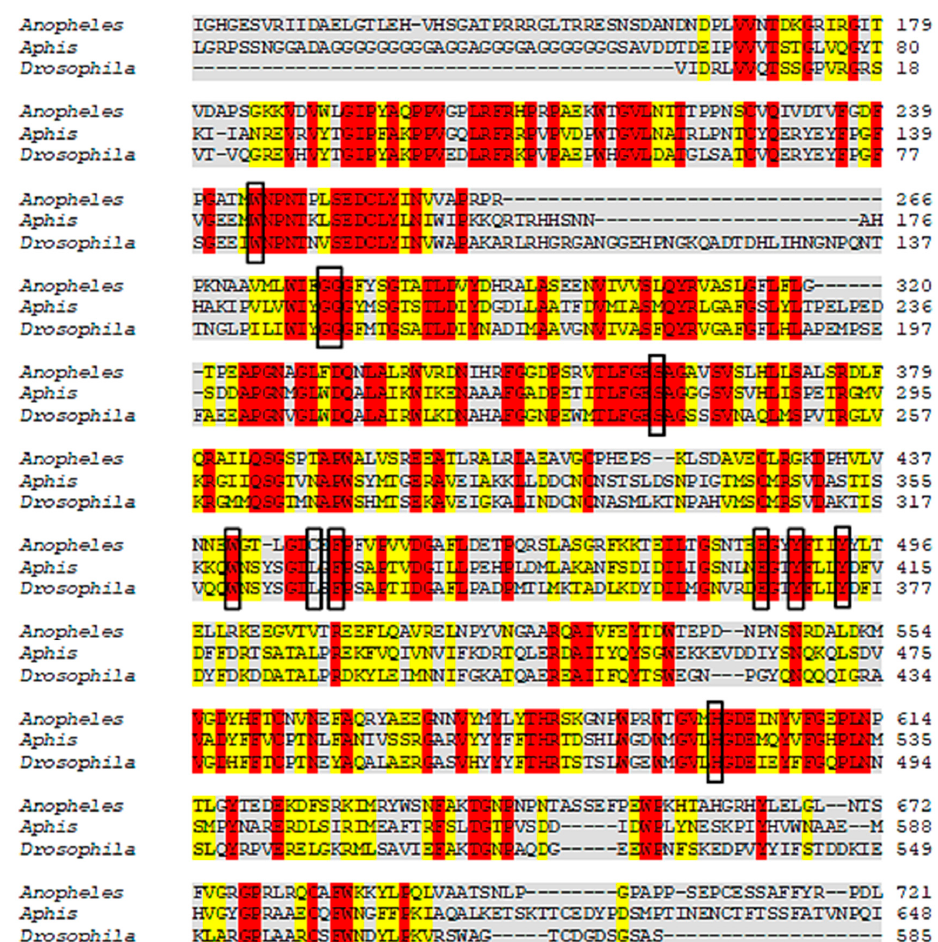
Figure 2. Alignment of Anopheles gambiae , Aphis gossypii, and Drosophila melanogaster Acetylcholinesterase (AChE) protein sequences. The gray regions represent non-similar and non-identical amino acids. The red regions represent identical amino acids. The yellow regions represent similar amino acids. The black boxes represent conserved regions of the active site which bind to the inhibitor. Molecules 2021 , 26 , x FOR PEER REVIEW